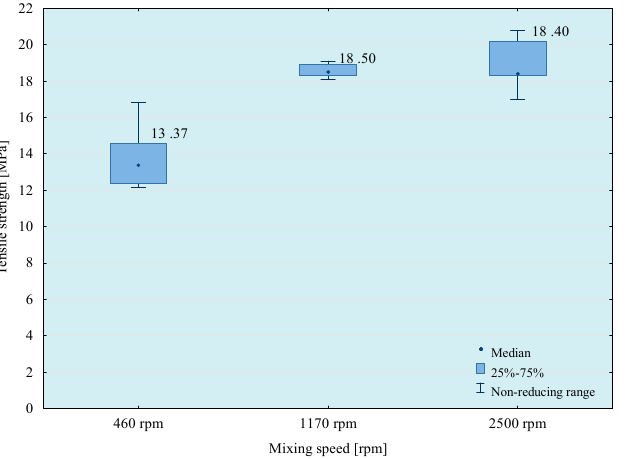
Figure 9. Tensile strength of E57/Z-1/CaCO 3 /100:10:20 composition as a function of mixing speed.